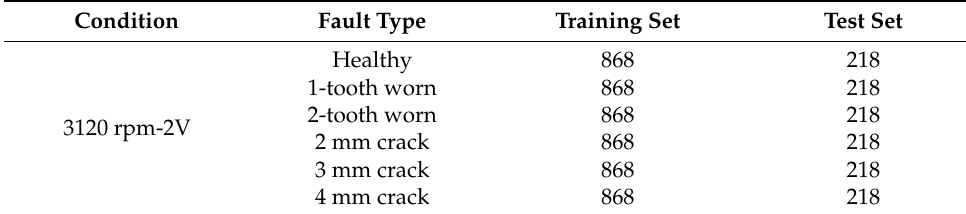
Table 3. Details of the gear datasets.